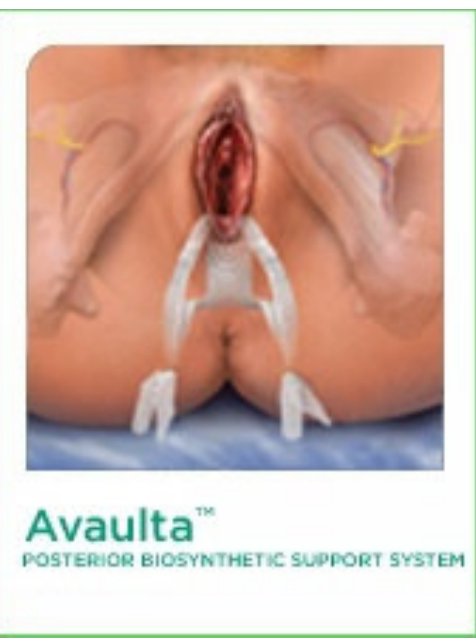
FIGURE 4. Avaulta System by Bard